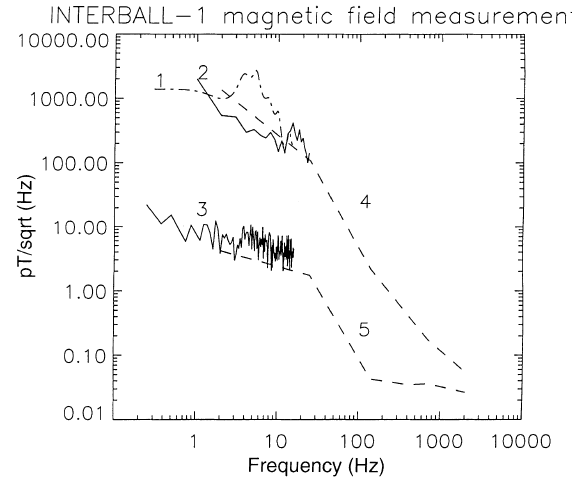
Fig. 2. Noise levels of the magnetic sensors. Curve 1: bow shock spectrum from the PROGNOZ-10 BUD-1M experiment; curve 2: bow shock spectrum (FFT of the wave form); curve 3: noise spectrum (FFT of the waveform); curve 4: bow shock spectrum (filter bank); curve 5: noise spectrum